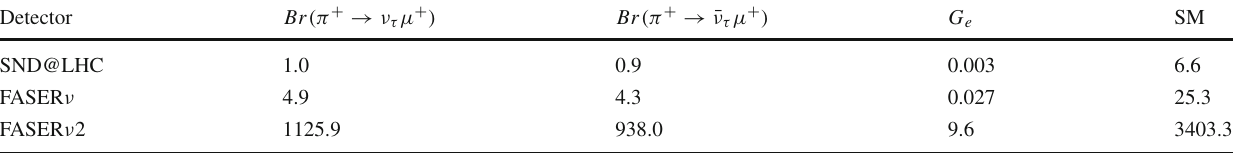
Table 5 Total expected number of τ events at FASER ν and SND dur- ing the run III and at FASER ν 2 during the high luminosity run of the LHC. To compare the values, we have saturated the bounds on the new physics, setting G e equal to 5 × 10 − 7 GeV − 2 and the branching ratios